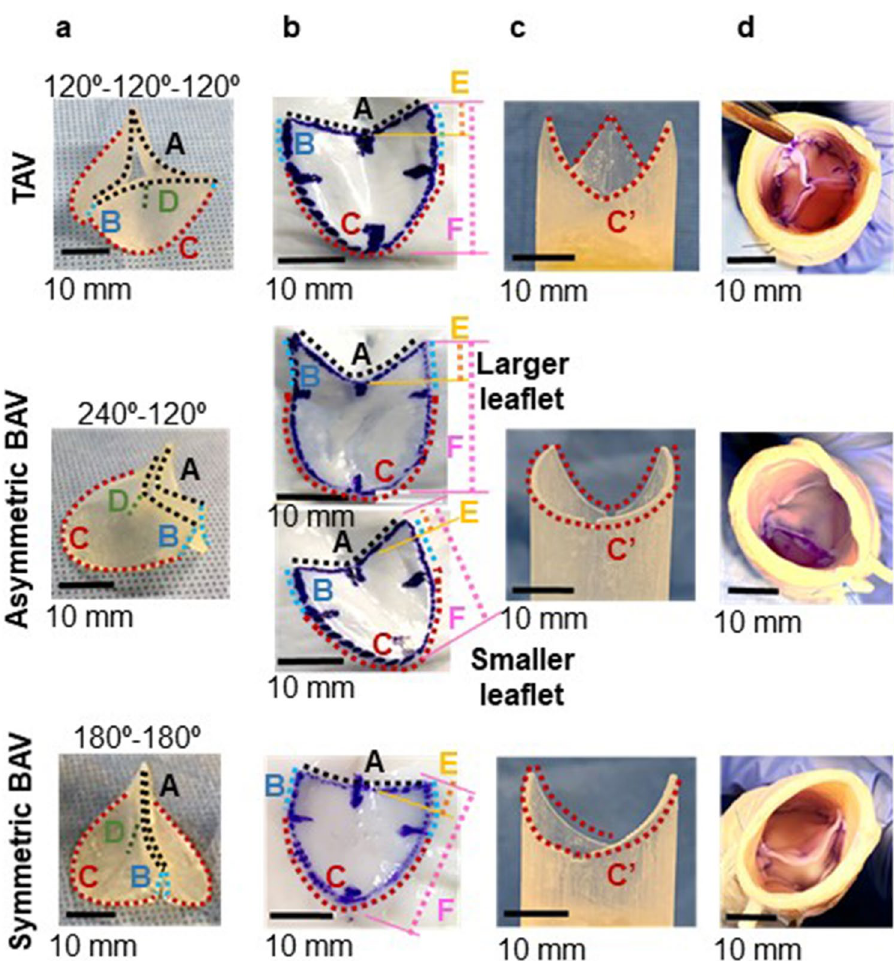
Figure 1. The devices and procedures used in preparing the aortic valve models. ( a ) Morphotype-specific leaflet-trimming three-dimensional templates for preparing pericardial leaflets. ( b ) Pericardial leaflets in tricuspid aortic valve (TAV), asymmetric bicuspid aortic valve (ABAV), and symmetric BAV models. Bovine pericardium is pressed on the templates and cut along their edges. ( c ) Morphotype-specific leaflet-suturing guides. Annular margins of pericardial leaflets (C) are sutured to the aortic wall along the annular curve of the suturing guide (C ′ ). ( d ) TAV, ABAV, and symmetric BAV models with annular diameters of 24 mm. A: free margin; B: commissural margin (length of 5.2 mm); C: annular margin; C ′ : annular curve; D: coaptation height (length of 6.2 mm); E: depth of the central portion of the leaflets from the upper edge of the commissures (length of 2.7 mm); F: leaflet length (length of 20